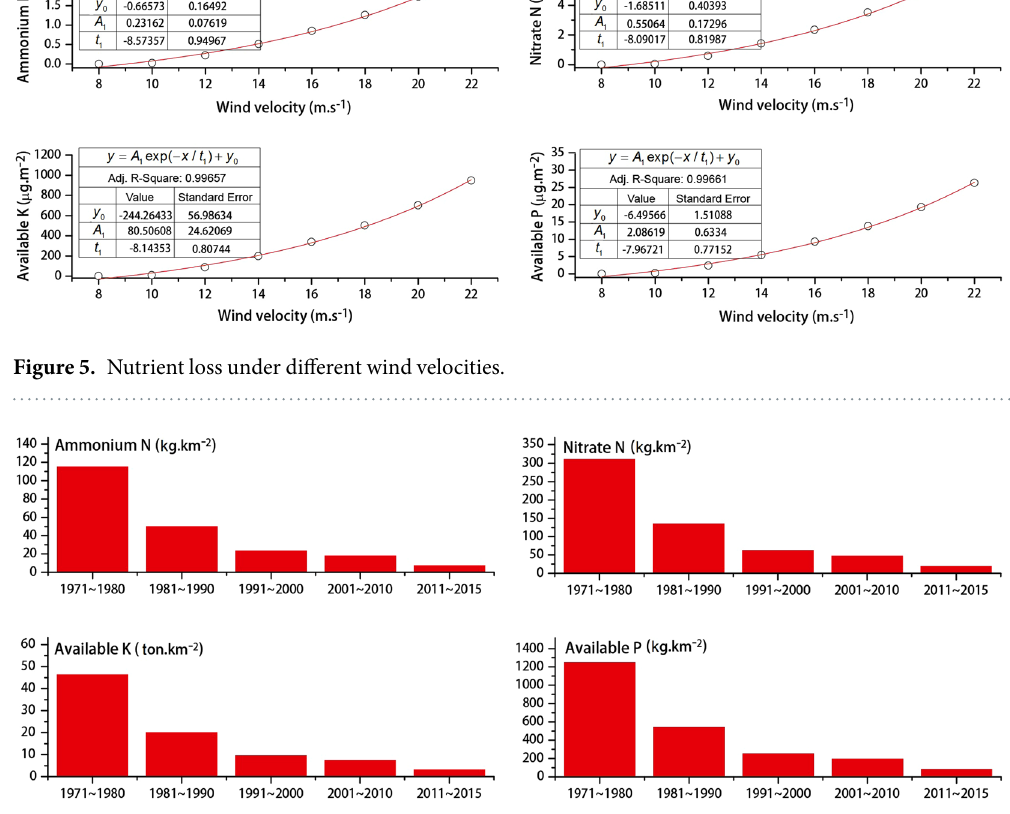
Figure 6. Nutrient loss under different wind velocities in the Mu Us Desert during different